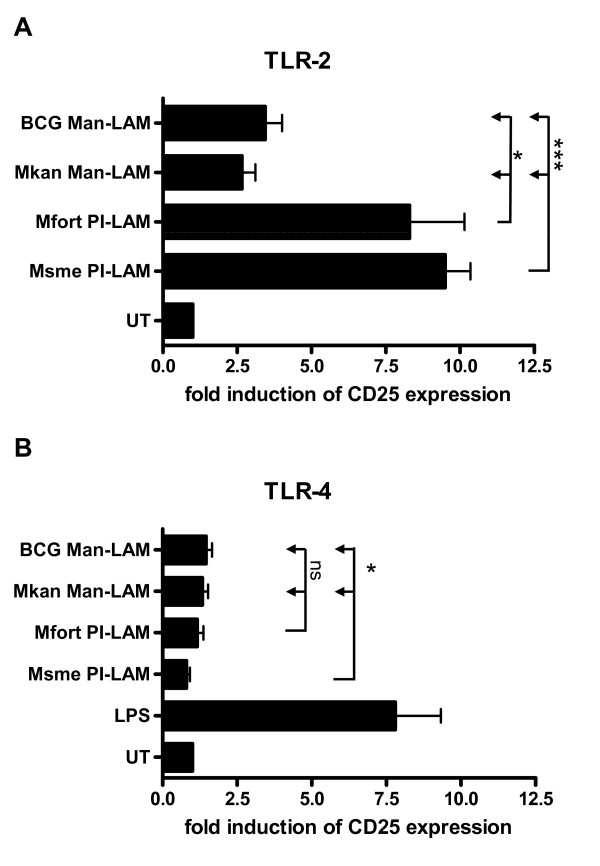
PI-LAMs activate cells in a TLR-2-dependent manner. A. CHO/CD14/TLR-2 and B. CHO/CD14/TLR-4 reporter cell lines were incubated with the indicated lipoglycans at 20 μg/ml or LPS at 1 μg/ml for 16 h. Cellular activation was measured by determining the expression of CD25 at the cell surface by using anti-CD25 monoclonal antibodies and flow cytometry. The mean fluorescence intensities were determined and the fold induction over untreated cells was calculated and the mean and standard deviation of three independent experiments is shown.